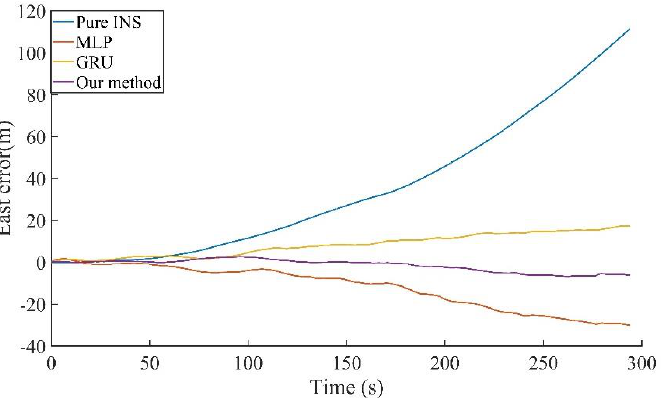
Figure 16. The east position error result of 300 s outage of Experiment 1.